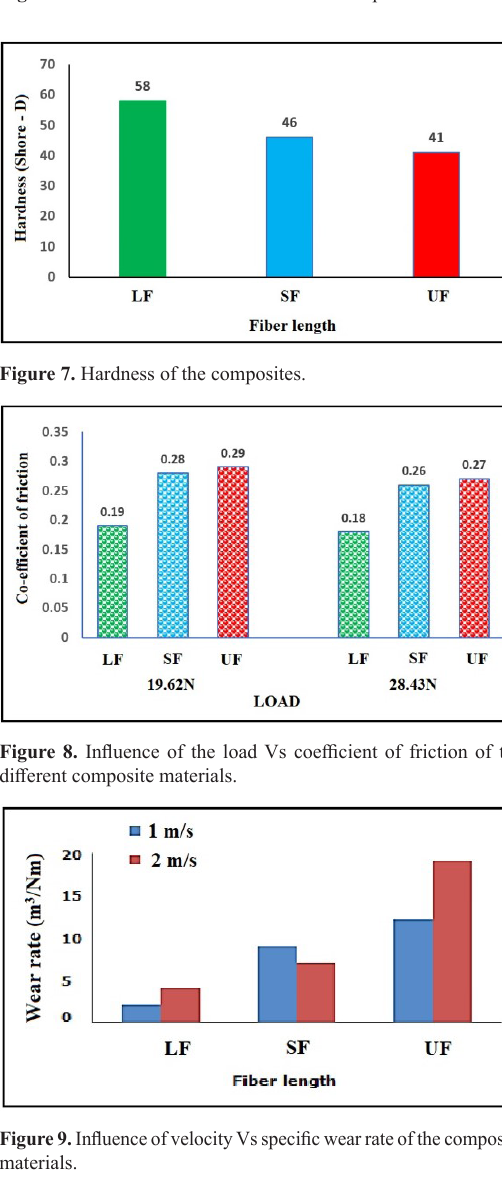
Figure 6. SEM of fractured surface of LF composites.